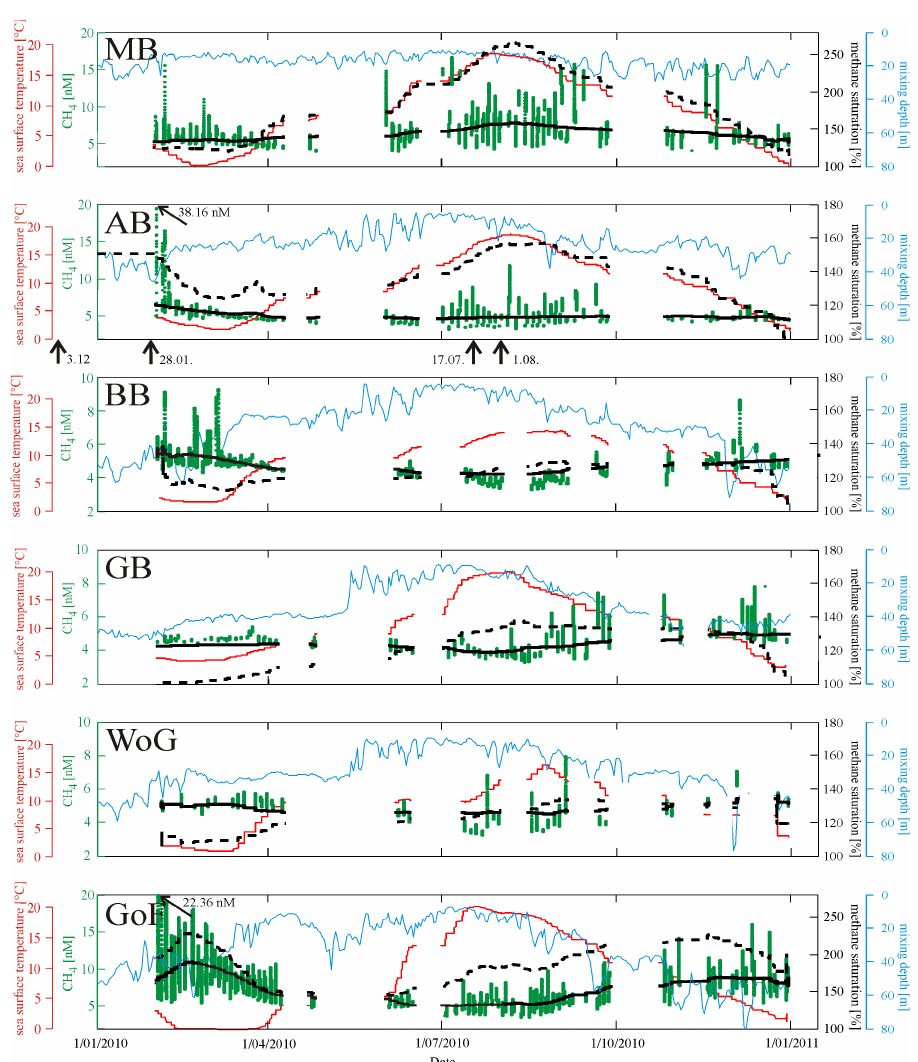
Fig. 7. Compilation of various data sets for the interpretation of the seasonal methane distribution. Sub-charts show measured time series of methane concentrations (green points) for each passing of the selected area (Table 1), its three day average (black solid line), maximum mixing depth (blue line, daily average), methane saturation (black dotted line, three day average), and sea surface temperature (red line, three day average) for Mecklenburg Bight (MB), Arkona Basin (AB), Bornholm Basin (BB), Gotland Basin (GB), West of Gotland (WoG) and Gulf of Finland (GoF). The arrows beneath subplot AB indicate the sampling date of the water column profiles shown in Fig. 5. Arrows in subplot AB and GoF show maximum values of methane concentration. Note the two different scales for methane concentration and methane saturation used for the individual subplots.